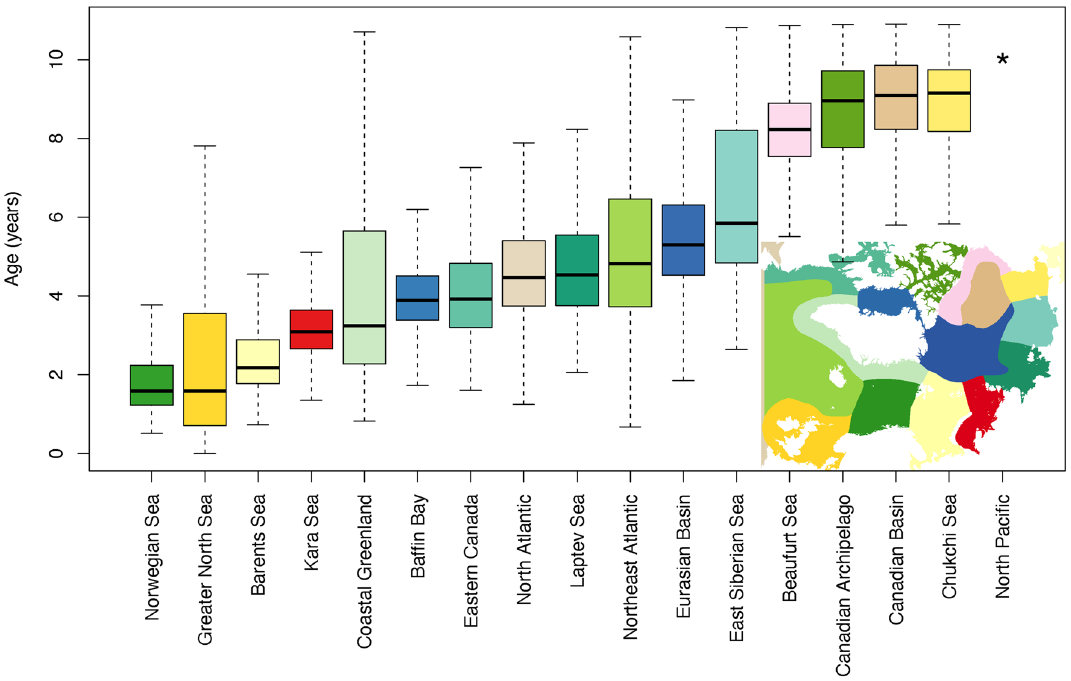
Figure 4. Transport time of European BMP to the regional seas of the Arctic Mediterranean measured as simulated travel time from initial discharge along the North Sea riverine-coastal domain. Here boxes and solid black line represents the 1st, 2nd (median) and 3rd quartile of the distributions, the “whiskers” 1.5 × interquartile range, and open circles outliers. Color of boxes refers to the corresponding regional sea or area which extent is demarcated in small inset. *Note that no particles entered the Bering Sea (North Pacific) in our simulations, thus no minimum age could be estimated.